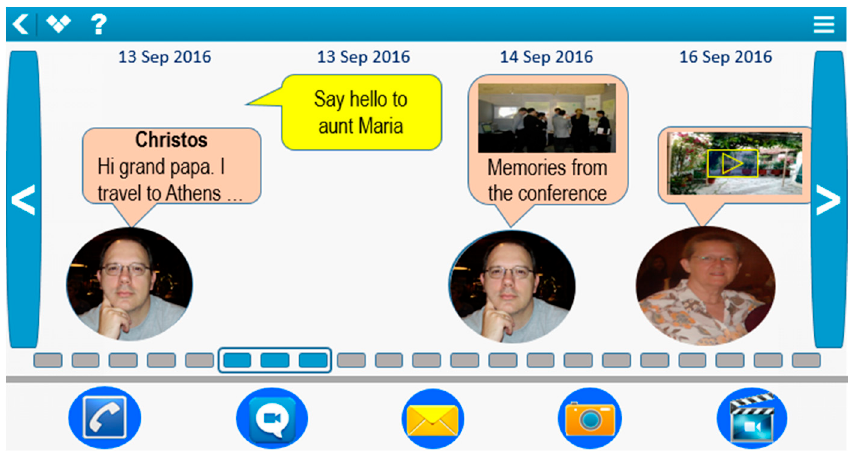
Figure 6. Timeline-based information shared by a person with family and friends.